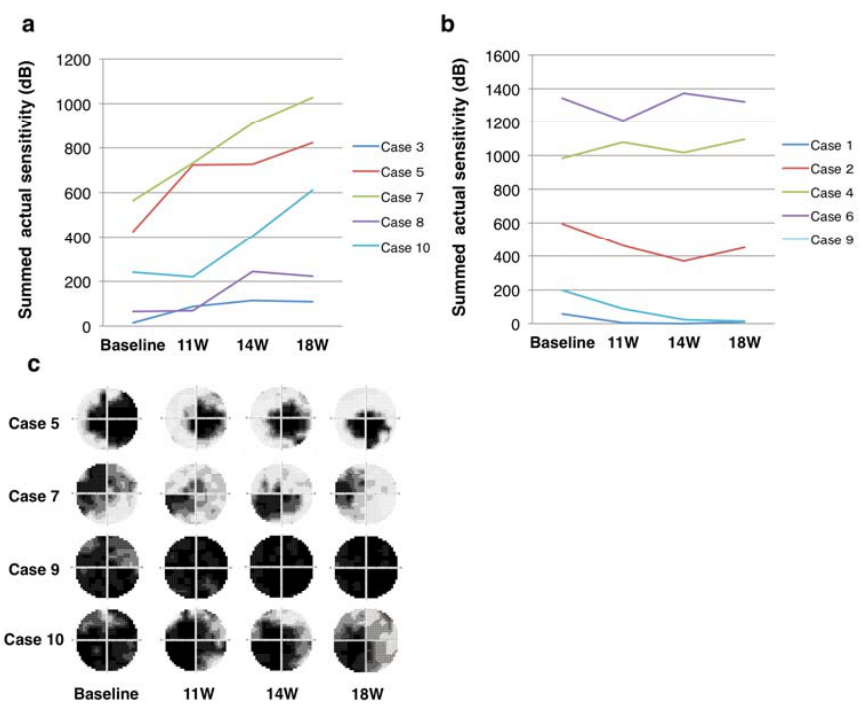
Figure 4. Time course of changes in summed actual sensitivity at 52 test points (except outermost points). ( a ) the effective group showing the increase of summed actual sensitivity compared with baseline; and ( b ) ineffective group showing no improvement. ( c ) The Humphrey visual field grayscale in four representative cases that had improved visual fields (Cases 5, 7, and 10) and deterioration of visual field (Case 9).